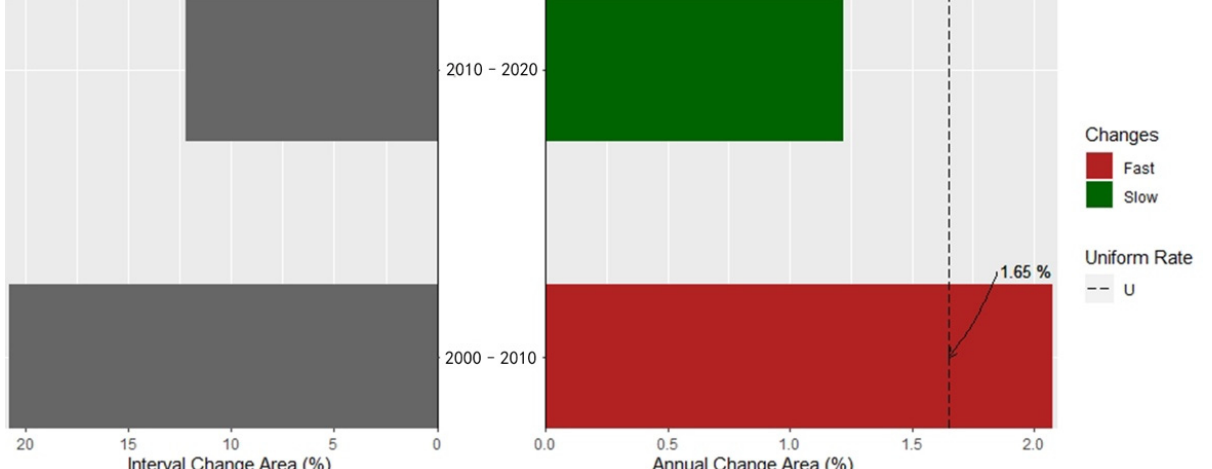
Figure 5. Time intensity analysis for two time intervals: 2000 to 2010 and 2010 to 2020. The left side represents gross area of overall change in each interval, and the right side represents the intensity of annual area of change within each interval. The dash line represents the uniform annual intensity of change from 2000 to 2020. If a category’s bar extends beyond the uniform line, then the change of intensity is fast. If a category’s bar ends before the uniform line, then the change of intensity is slow. The category level further explores the detailed change of each land-use category and helps detect which categories are dormant or active during different time intervals. last two decades. The dash lines represent the uniform annual intensity of change in the respective time interval. The interval from 2000 to 2010 (2.08%) had a larger annual rate of intensity gain than the interval from 2010 to 2020 (1.22%). From 2000 to 2010, the gain of artificial surfaces, cultivated land, and grassland was dormant, and the gain of forest and water bodies was active. Although forest had the largest size of gain, the gain of water bodies was more intensive. From 2010 to 2020, artificial surfaces experienced the largest gain intensity, followed by grassland and water bodies. The gain of cultivated land and forest was